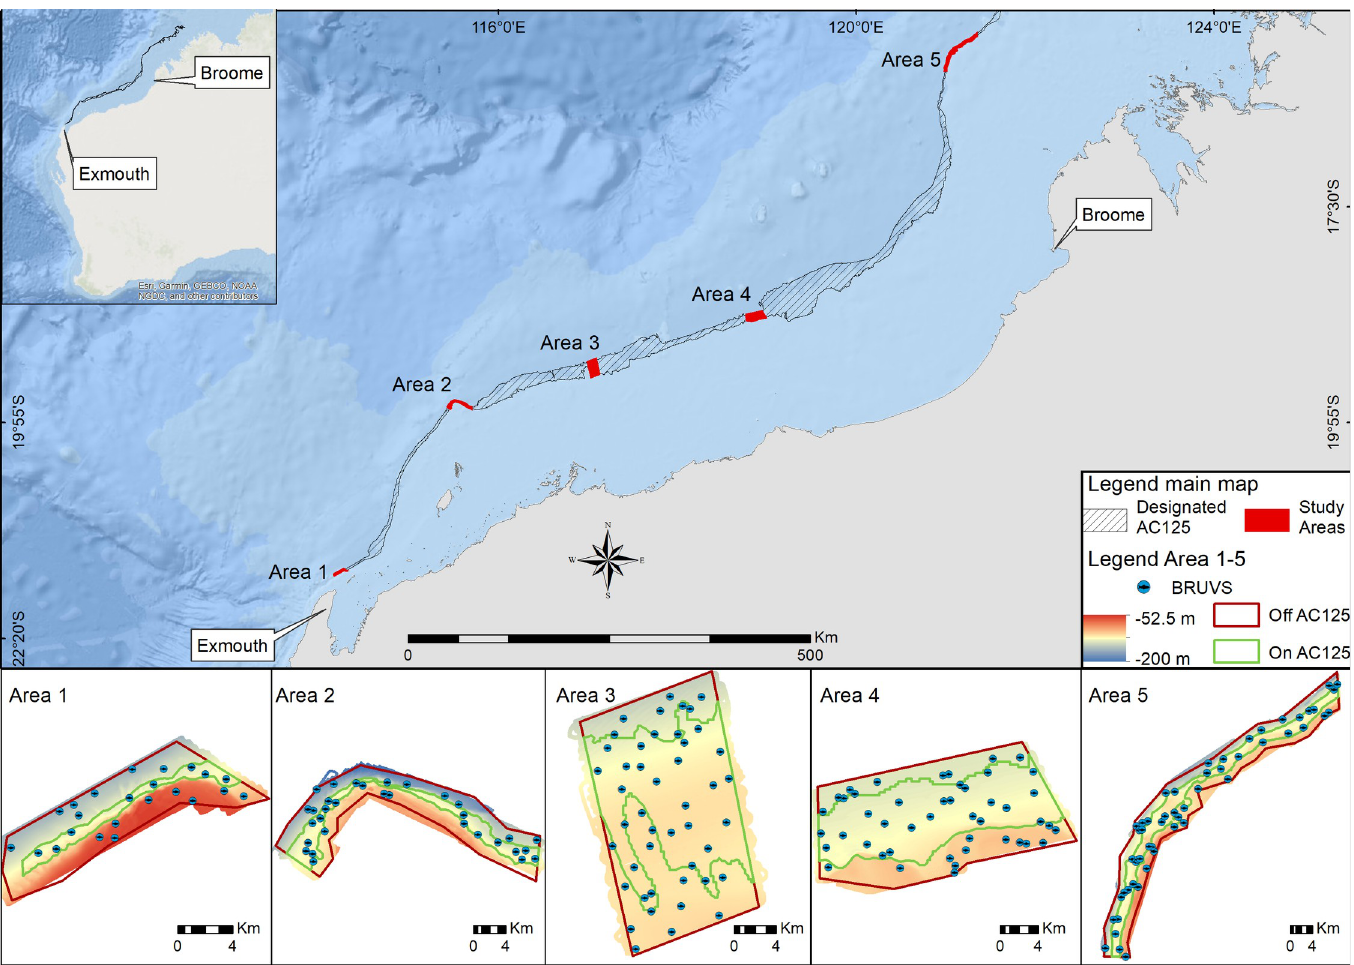
Fig 1. Location of sampling within the five sampling areas along the designated AC125 (crosshatched polygon), depth and BRUVS deployments (points). Within the designated AC125, on AC125 is defined as between 115-135m depth based on existing bathymetry for this region [42]. This map was generated using ESRI software.